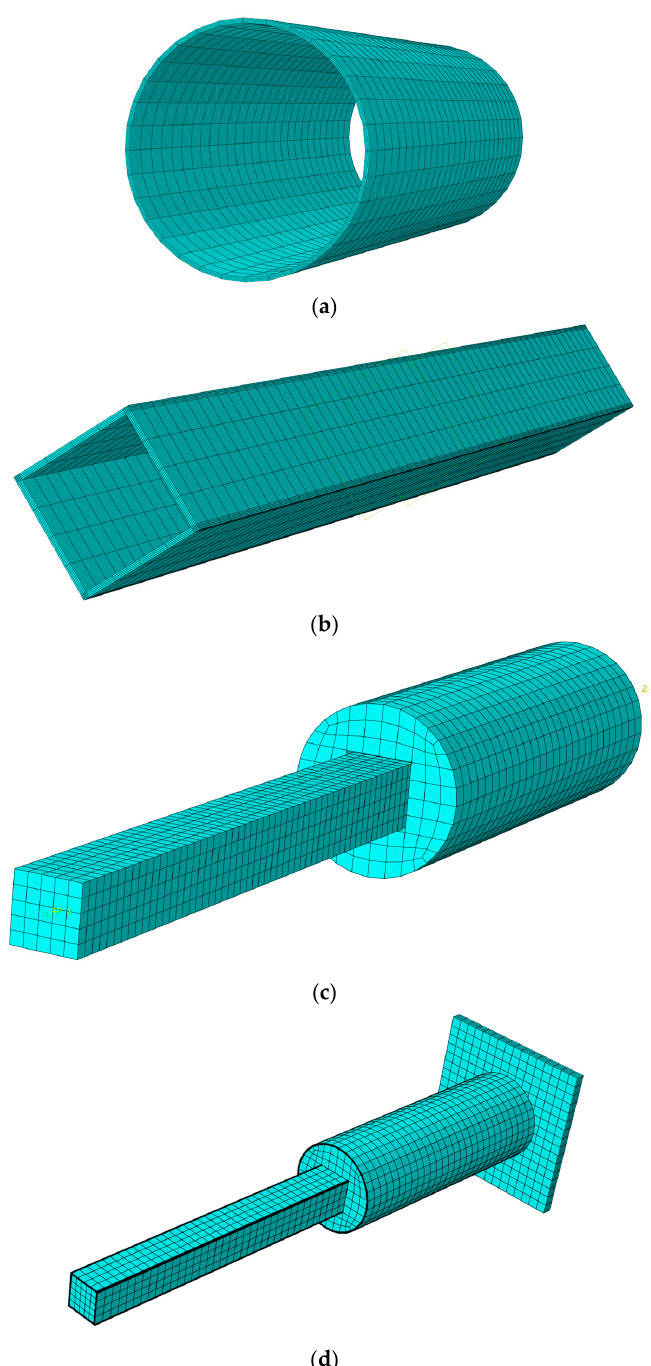
Figure 13. Meshing diagram of each component: ( a ) circular steel tube meshing; ( b ) square steel tube meshing; ( c ) concrete meshing; ( d ) overall model and meshing.